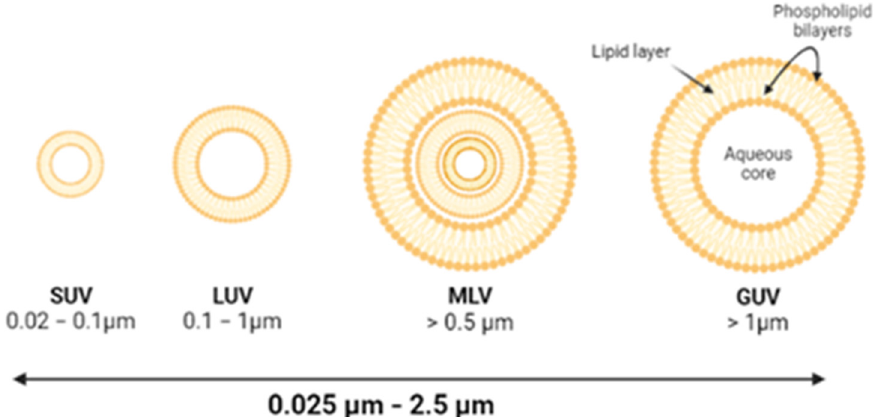
Figure 1. Classification of the liposomes based on their size and number of lipid layers. SUV, small unilamellar vesicle; LUV, large unilamellar vesicle; MLV, multilamellar liposome vesicle; GUV, giant unilamellar vesicle.